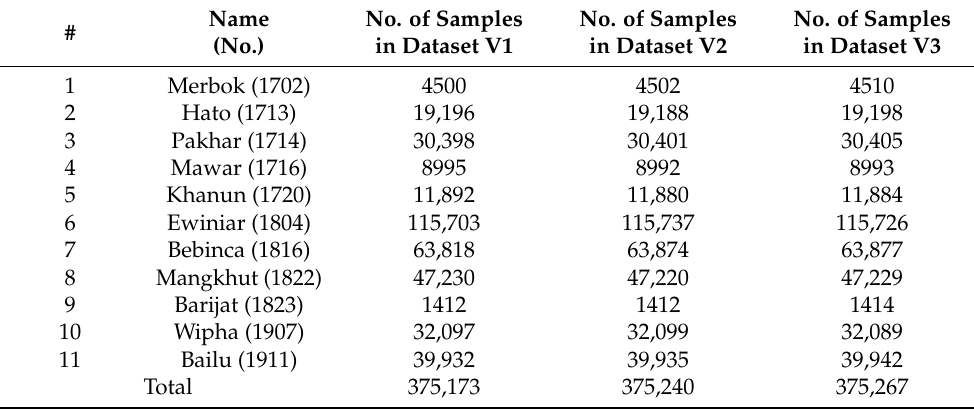
Table 2. Sample information of the “DPO—SR”